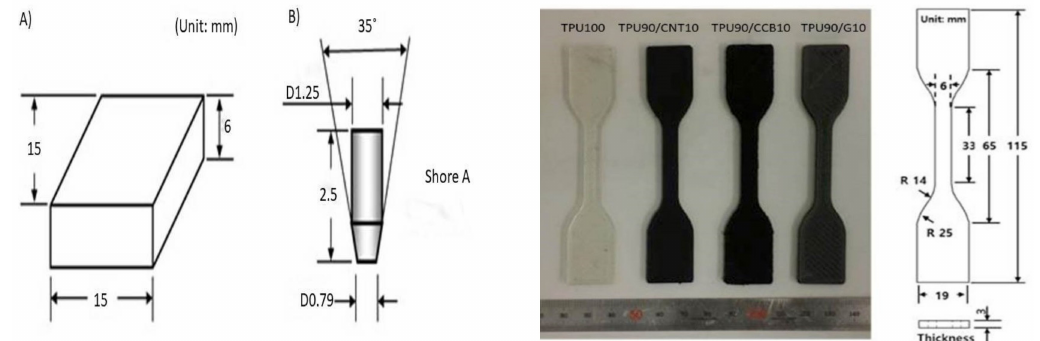
Figure 2. Dimensions of ( A ) Shore hardness test specimen, and ( B ) flat cone-shaped type A indenter (left) and TPU / C composite dog-bone style samples; dimensions of ASTM D638 Type IV tensile test specimens (right).